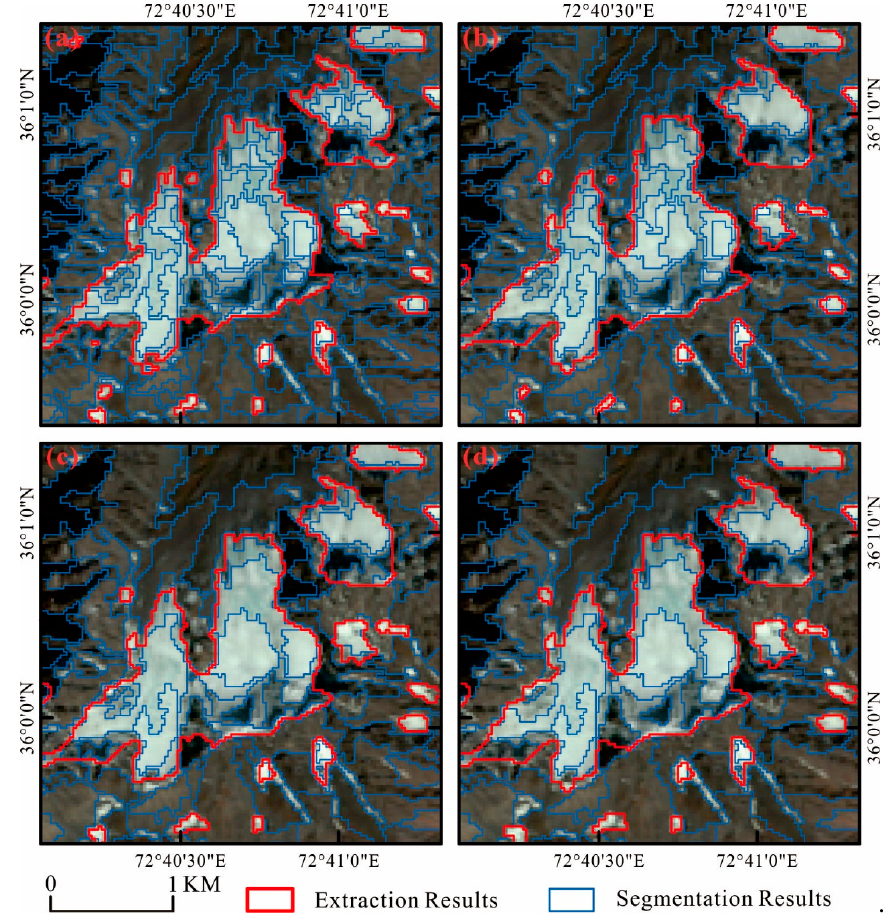
Figure 7. The delineated boundaries of ice/snow under different segmentation scales: ( a ) 10; ( b ) 15; ( c ) 20; and ( d ) 25.